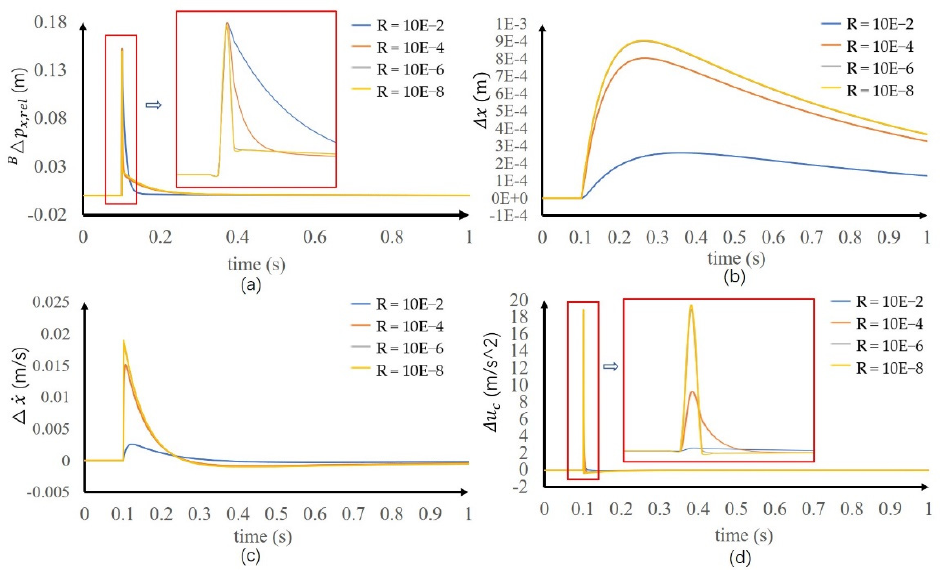
Figure 3. Simulation results of zero moment point (ZMP) error control. ( a ) ZMP error. ( b ) COM position increment. ( c ) COM velocity increment. ( d ) Control input.